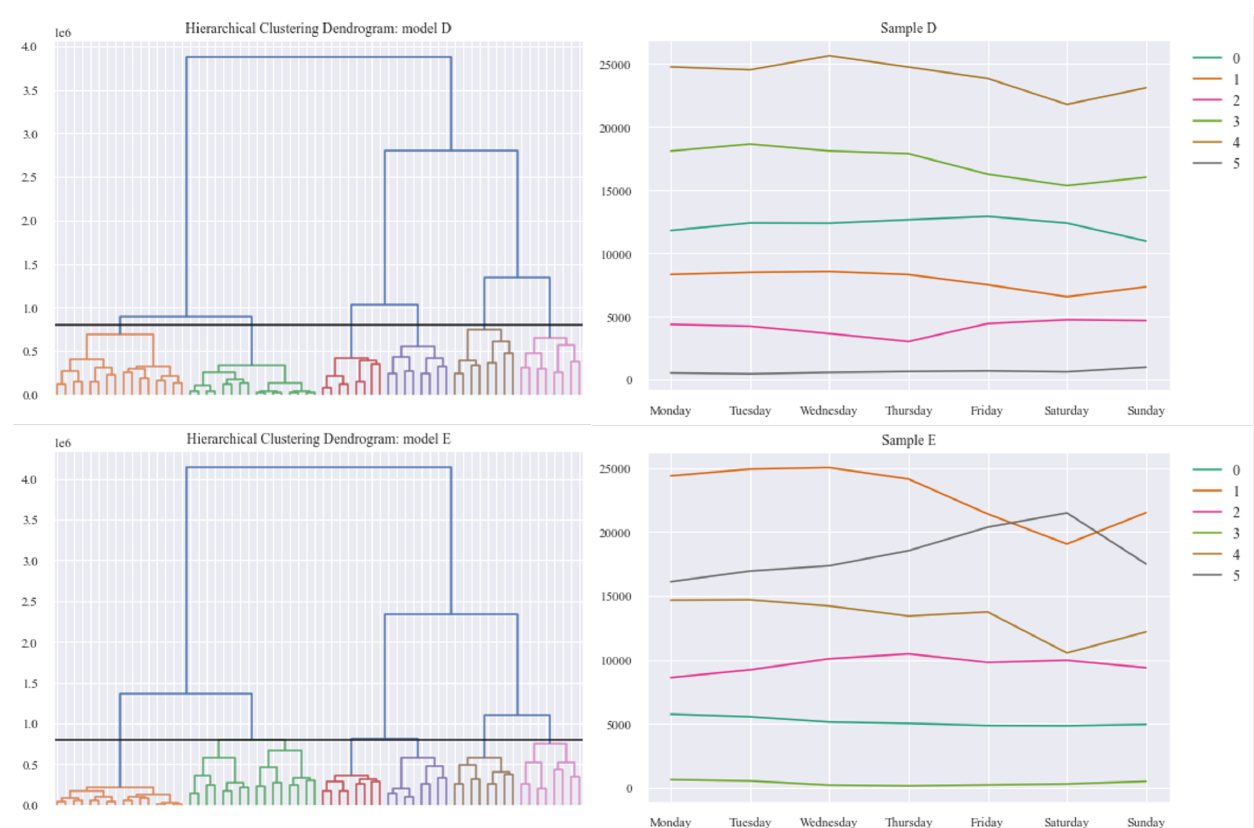
Figure A3. Dendrograms and corresponding activity patterns (N = 6) for agglomerative clustering of the five samples of weekly physical activity